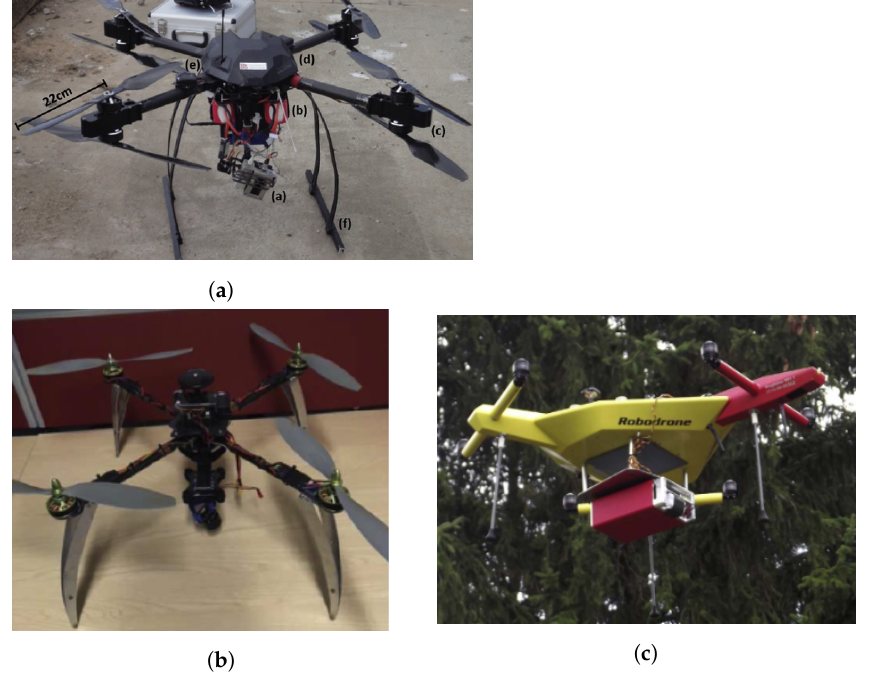
Figure 8. Examples of detectors coupled to air-based platforms: ( a ) Multi-rotor UAV with a Cadmium Zinc Telluride (CZT) and a single-point light detection and ranging (LiDAR) mounted in a gimbal. Reproduced, with permission, from Reference [159]; published by Elsevier, 2016, under the terms of the https://creativecommons.org/licenses/by/4.0/CC BY 4.0 license. ( b ) Multi-rotor UAV with a SIGMA-50 CsI(Tl) detector and a single-point laser rangefinder. Reproduced, with